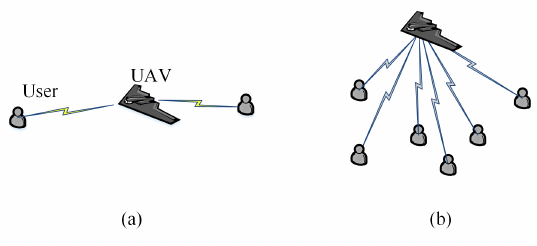
Figure 1. Network structures: ( a ) end-to-end communication; ( b ) multi-agent inter